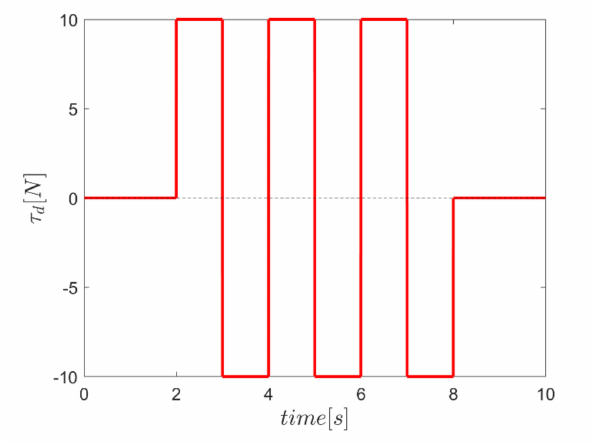
Figure 16. External square input disturbance in the rotating channels.